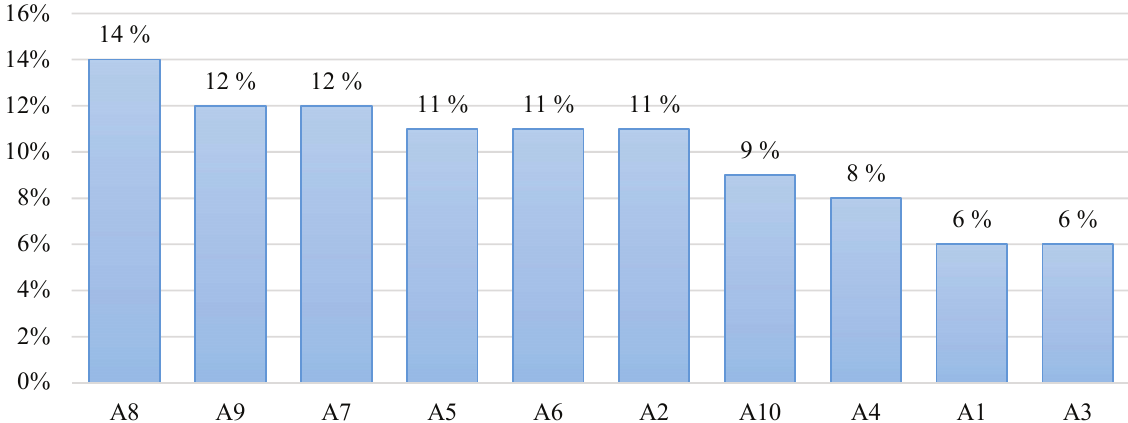
Fig. 2. Distribution of opinions of the surveyed applicants on higher popularity and positive attitude to NUPh: A1 –